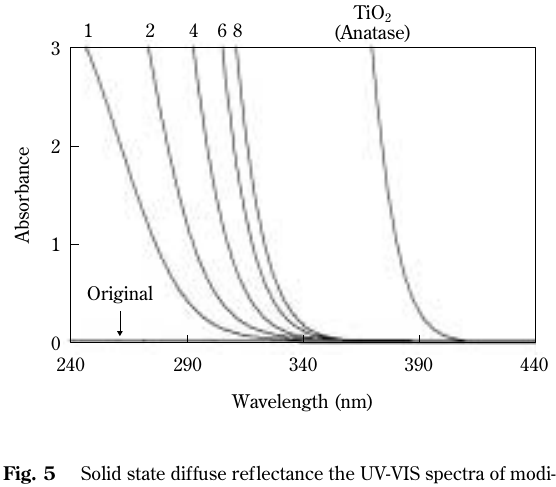
Solid state diffuse reflectance the UV-VIS spectra of modi- fied samples and Anatase. The number is the number of repetitions.